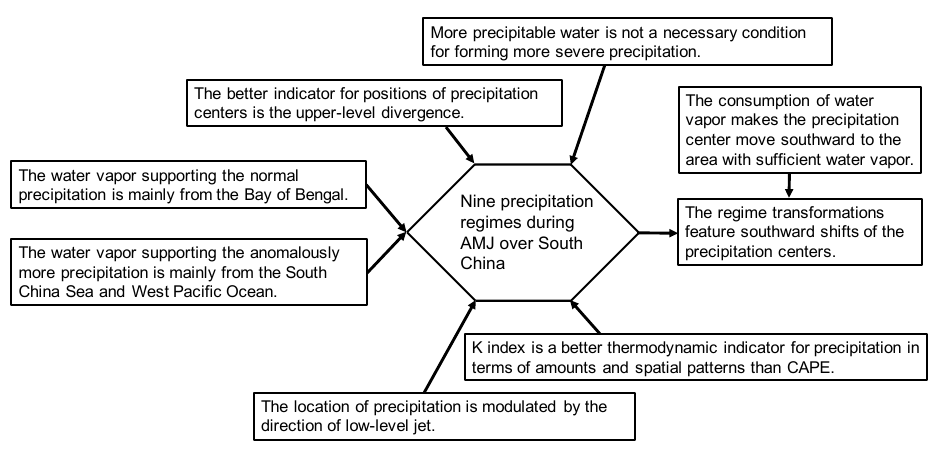
Figure 14. A diagram for the major findings of our